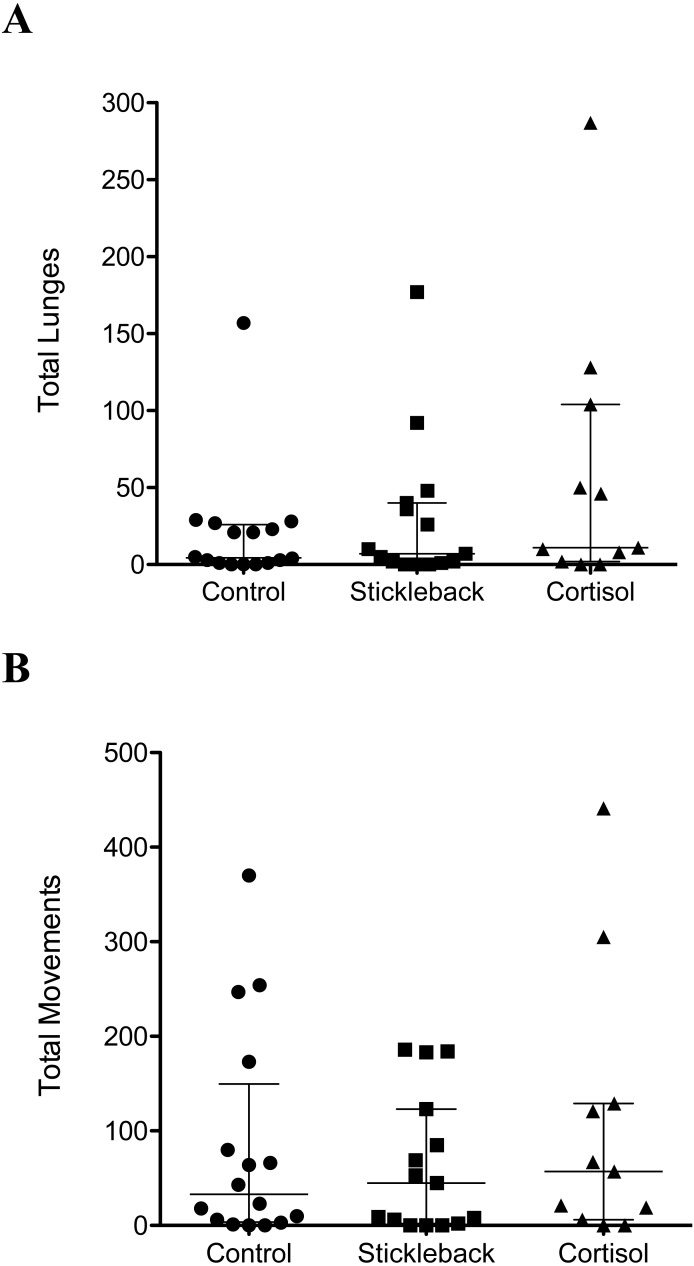
Scatter dot plots showing how chemical cues influenced perch behavior.Scatter dot plots showing median ± inter-quartile range of (A) the total lunges by perch at sticklebacks in the chemical stimulus zone, and (B) total movements between zones by perch. n = control, 16; stickleback natural cues, 15; cortisol, 11.